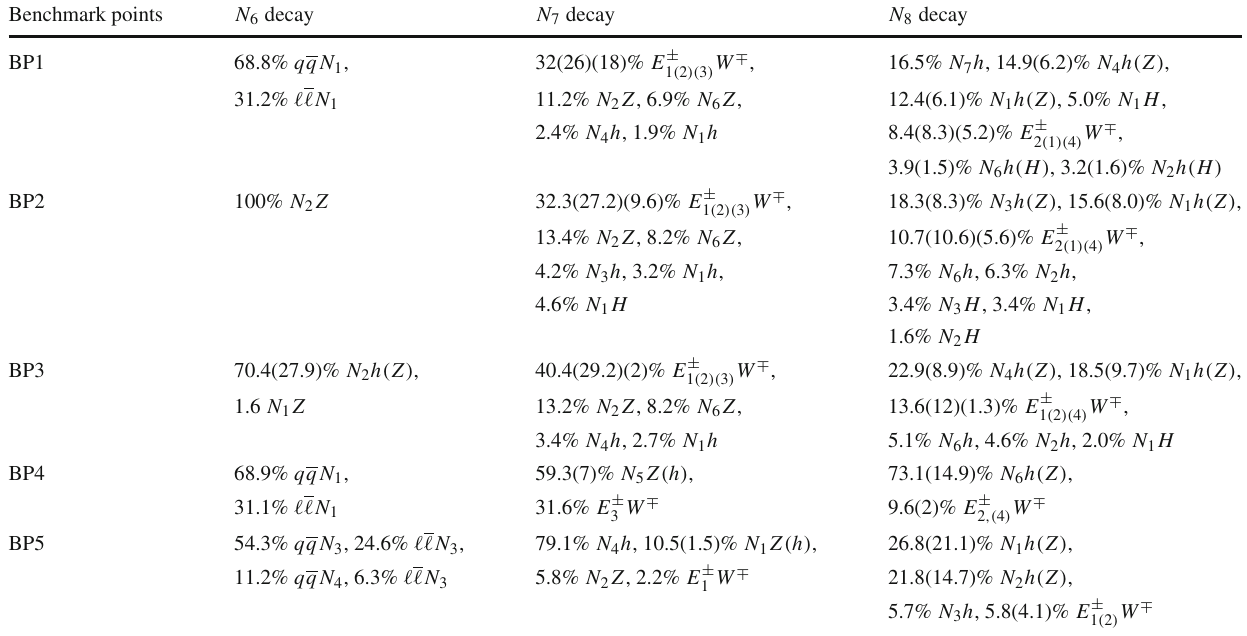
Table 20 Decay modes for neutral VLL (cont.d) Benchmark